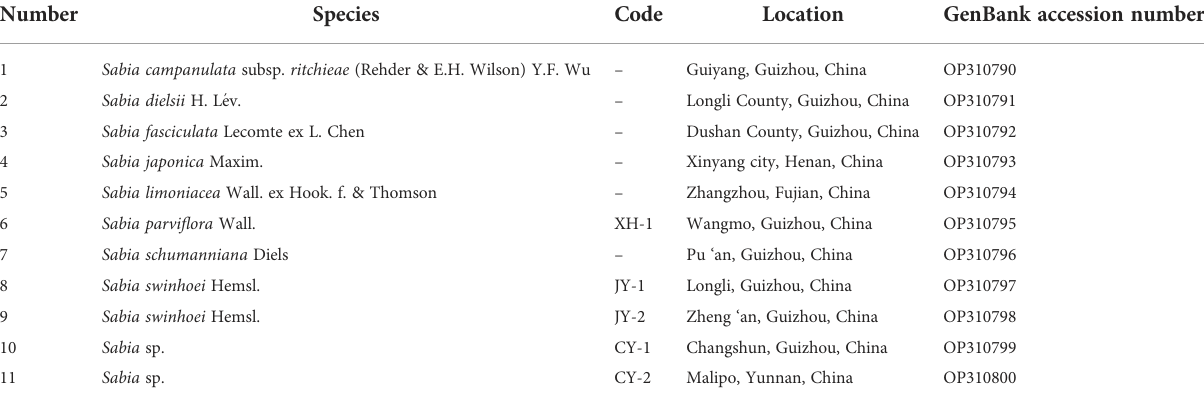
TABLE 1 Information on the samples of genus Sabia